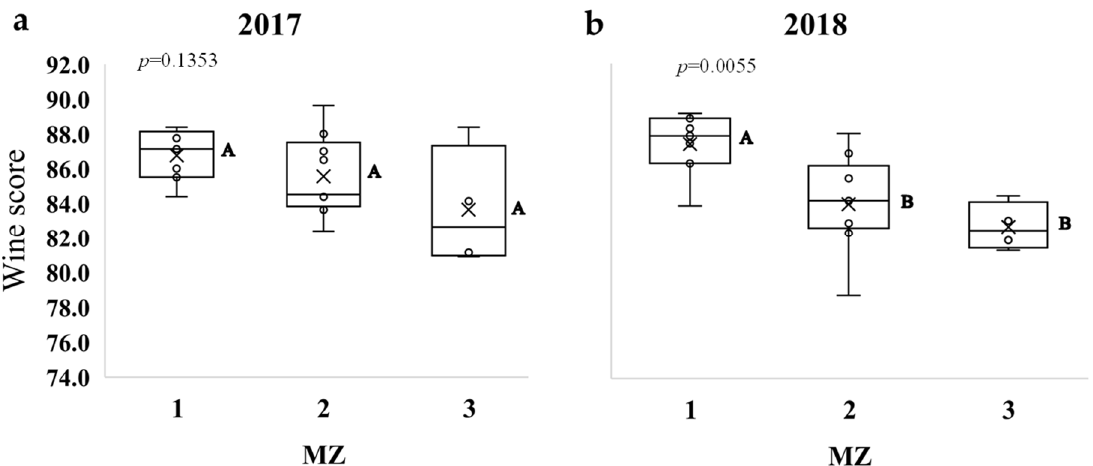
Figure 14. Whisker boxplot of wine scores in the ( a ) 2017 and ( b ) 2018 seasons, signifying the wine quality for the management zones. Each point is the mean of the winemaker’s evaluation of each of the 20 management cells. Significant differences among management zones (MZs) were calculated using ANOVA ( α = 0.05). Different letters represent significant differences between MZs.